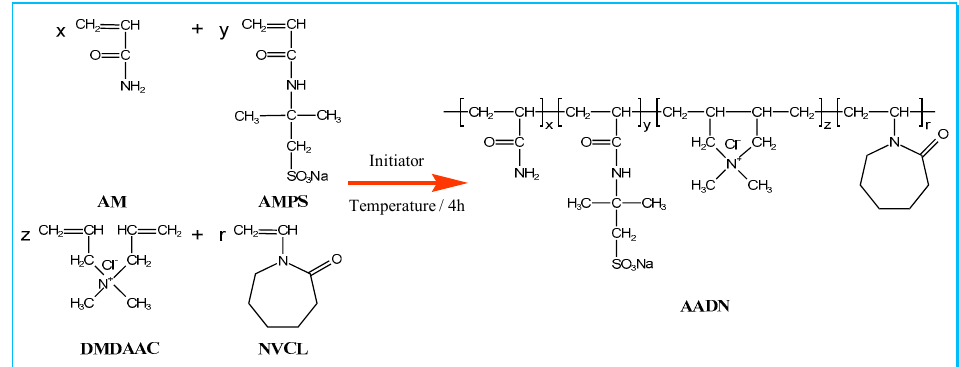
Scheme 1. Possible reaction roadmap of